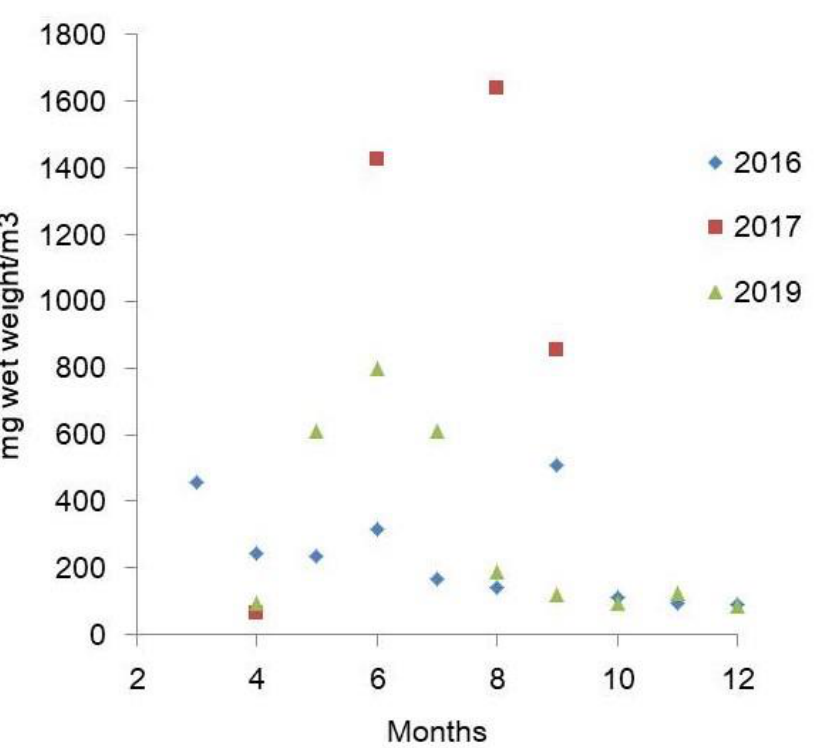
Figure 4. Dynamics of phytoplankton biomass in the NE the Black Sea at the station above a depth of 500 m.